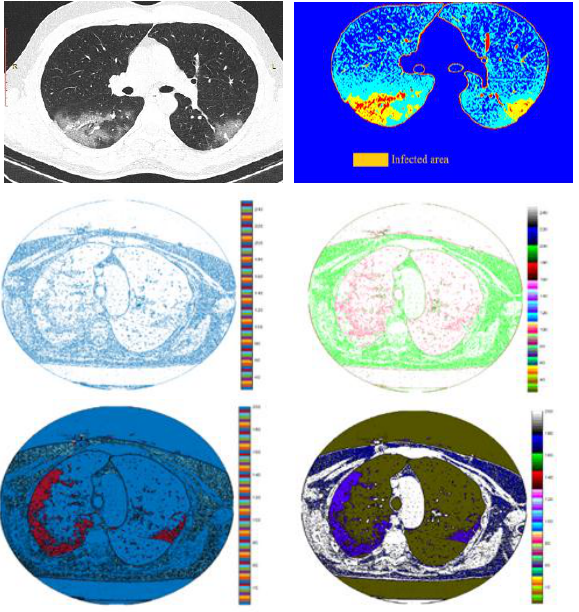
Figure 4. Examples of segmentation and color coding of lungs with COVID-19.